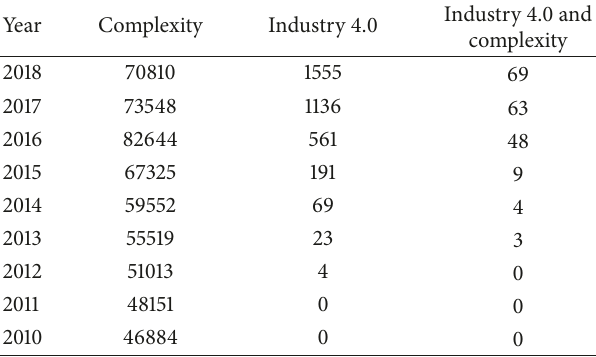
Table 1: Number of scientific publications on complexity and Industry4.0 (Resultsfrom theWeb of Science. Timespan: 2010-2018; All databases; Field tag: